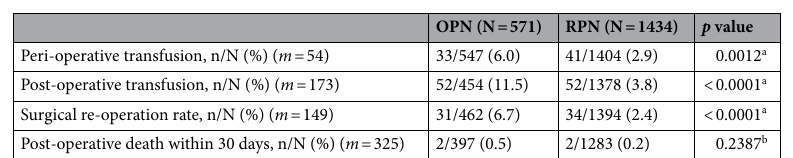
Table 3. Peri-operative morbidity secondary outcomes according to the surgical approach ( N = 2005 surgeries). m missing data, OPN open partial nephrectomy, RPN robotic-assisted partial nephrectomy. a Chi-squared test. b Fisher exact